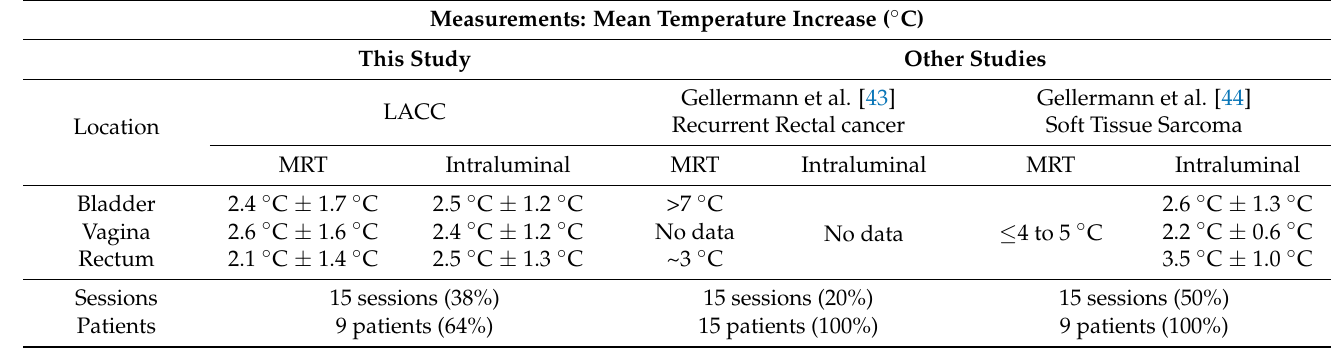
Table 3. Mean and standard deviation ( µ ± σ ) of temperature increase from MR thermometry measurements and intralumi- nal temperature measurements in delineated ROIs. The percentage of sessions and patients used in each study is compared with the total number. The mean temperature increase is reported for the dataset with low gastrointestinal air motion. MR thermometry measurements are expressed as MRT, and Intraluminal corresponds to the intraluminal measurements. Measurements: Mean Temperature Increase ( ◦